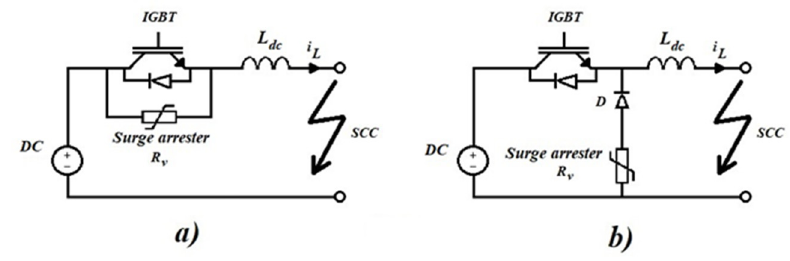
Figure 17. Solid-state circuit breaker ( a ) CB paralleling a surge arrestor, ( b ) SSCB with a freewheel- ing diode.